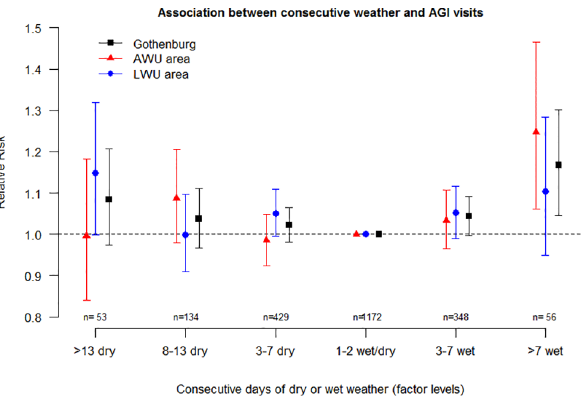
Fig 3. Association between consecutive weather and AGI visits. Effect of consecutive days of wet or dry weather on AGI visits. Bars represent 95% CIs, and n is the number of observation days in each factor level. One or two consecutive wet or dry days are set as reference